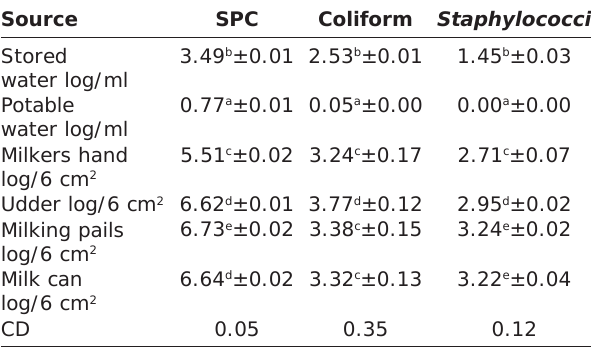
Table-1: Bacterial count of different potential sources of